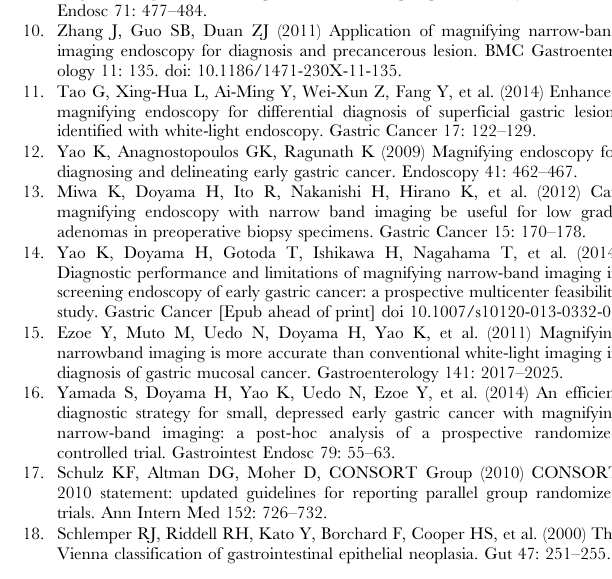
Table S1 Correspond to Table 3. (XLSX) Table S2 Raw data in each endoscopist and each question (still image test). Table S3 Raw data in each endoscopist and each question (moving image test). Table S4 Raw data of endoscopic experience and diagnostic accuracy in each endoscopist. Table S5 Raw data of diagnostic accuracy in each question.